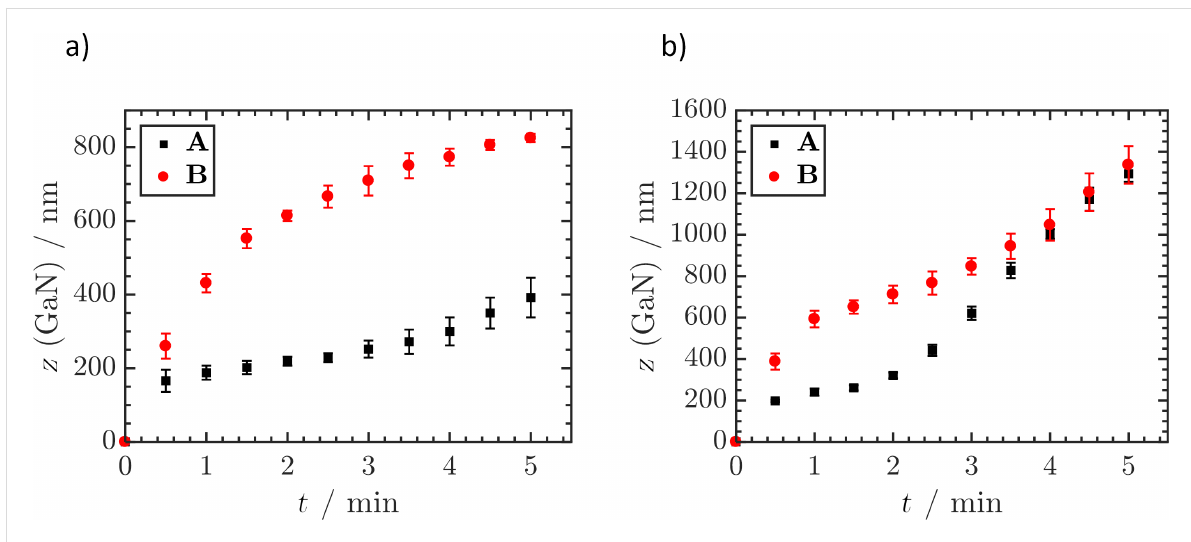
Figure 4: Average GaN removal z (GaN) of A and B during etching in 30 wt % KOH at 70 °C (a) and 80 °C (b) determined by ICP-OES. Values were determined as mean ± SDM, n =